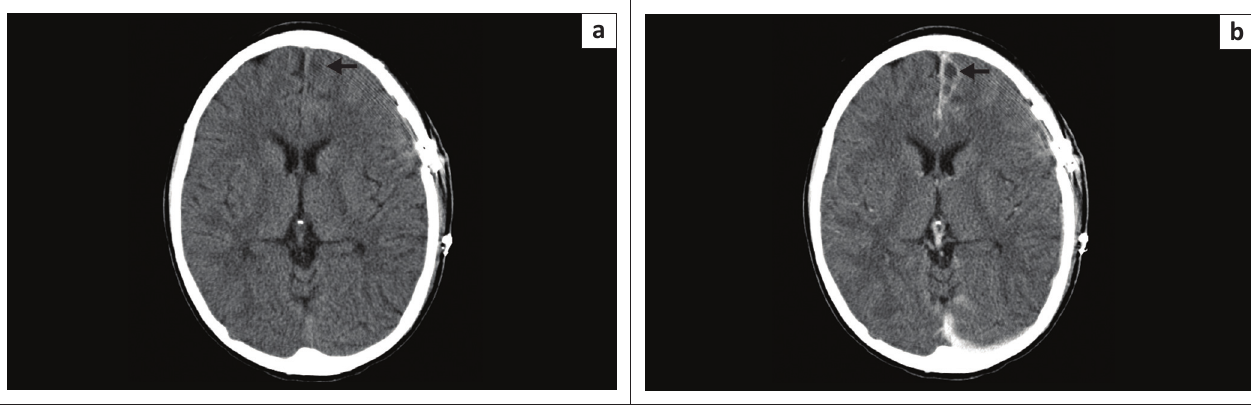
NECT, non-contrast-enhanced computed tomography; CECT, contrast-enhanced computed tomography. FIGURE 3: (a) NECT and (b) CECT of the brain. The NECT shows a vague parafalx hypodensity (arrow). This finding was undiagnosed during the first review and only identified on the CECT, which shows a small empyema (arrow).